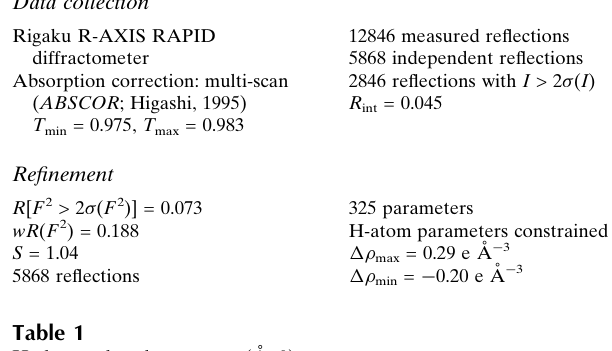
Hydrogen-bond geometry (A˚ , (cid:2) ). Cg 1 and Cg 2 are the centroids of the C3–C8 and C26–C31 rings,